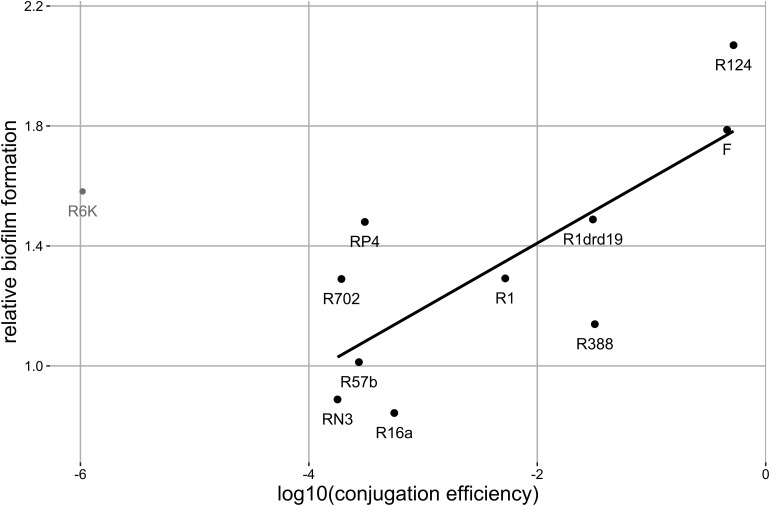
Correlation between biofilm formation and conjugation efficiency. Each data point represents the mean value for each plasmid (number of replicates as in Figure 1). The black line represents the regression line (y = 0.22x + 1.84, R2 = 0.59, σ2 = 0.07) for black points, where y is the biofilm production relative to the plasmid-free strain and x is the log10 of the conjugation rate. Gray point represents the excluded outlier. Significant correlation: Pearson method, two-sided, d.f. = 8, ρ = 0.77, p-value = 0.009.